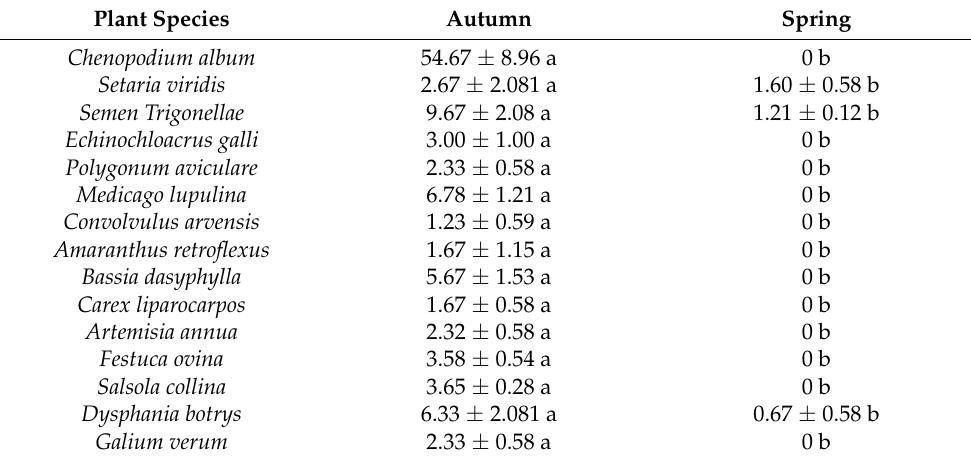
Table 4. Species and quantity of the germinated plant seedlings collected in sheep feces (plant/kg feces). Plant